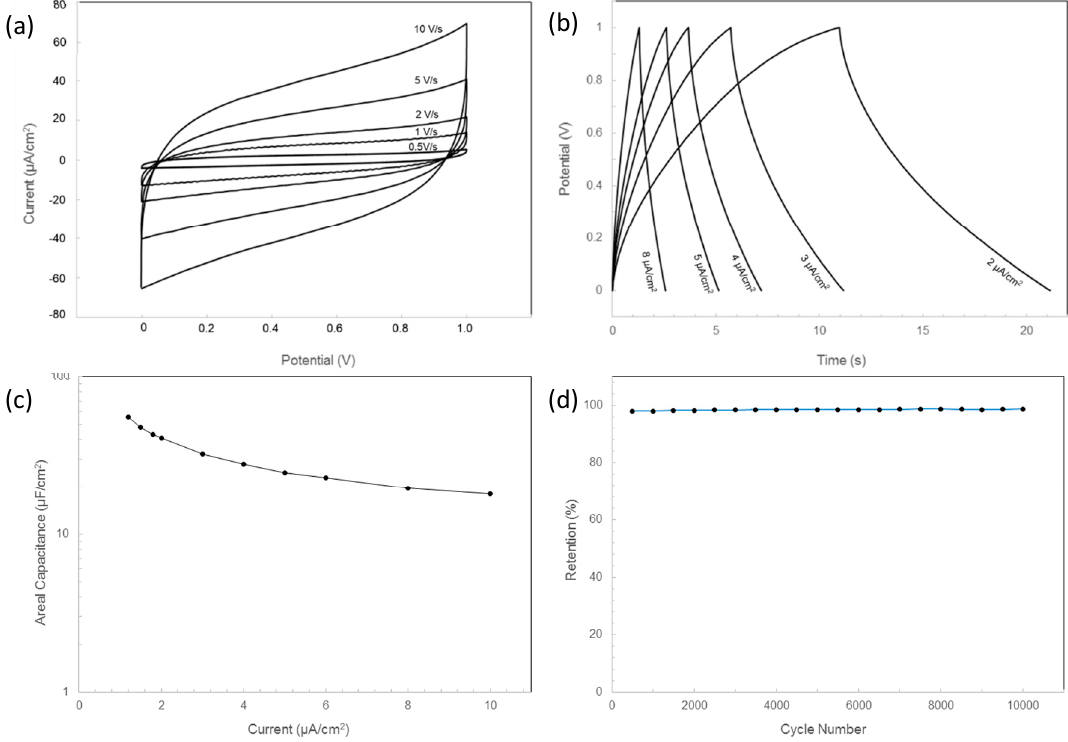
Figure 6. Electrochemical behavior of the LIG capacitor: Cyclic voltammetry (CV) curves of the LIG capacitor at scan rates of 0.5, 1, 2, 5, and 10 V/s ( a ); galvanostatic charge-discharge (GCD) curves at an electric current of 2, 3, 4, 5, and 8 µ A/cm 2 ( b ); C A calculated from GCD curves as a function of current density ( c ); and cycling performance at a current density of 1.2 μ A/cm 2 ( d ).